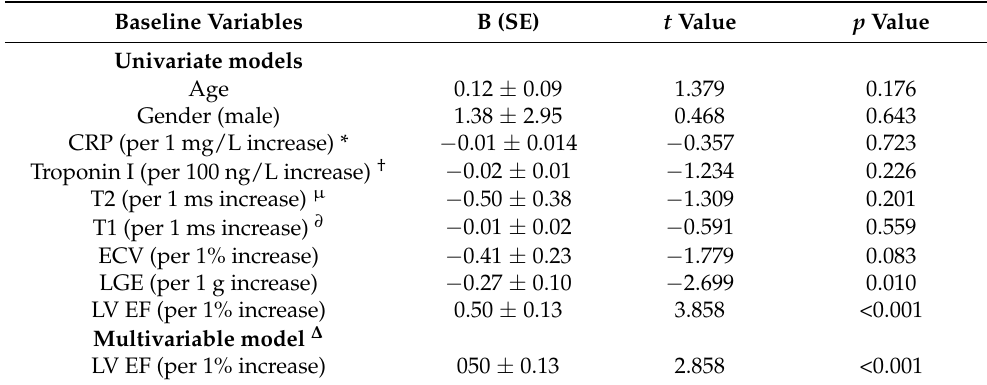
Figure 2. Multiparametric 1.5 T cardiac magnetic resonance in acute myocarditis. ( A ) Late gadolinium enhancement image showing focal enhancement in the inferolateral mid-wall (arrow). ( B ) T2 map. Inferolateral wall T2 elevated at 59 ms (arrow) compared to 47 ms in the anteroseptum. ( C ) Native T1 map. Inferolateral wall T1 elevated at 1286 ms (arrow) compared to 1009 ms in the anteroseptum. ( D ) Extracellular volume (ECV) map. Inferolateral wall ECV elevated at 53% (arrow) compared to 25% in the anteroseptum. Table 4. Factors associated with left ventricular recovery following acute myocarditis ( n =